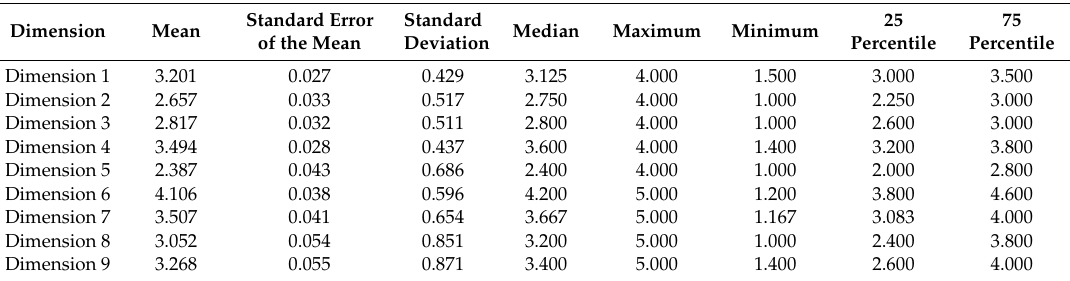
Table 2. Average score of HL